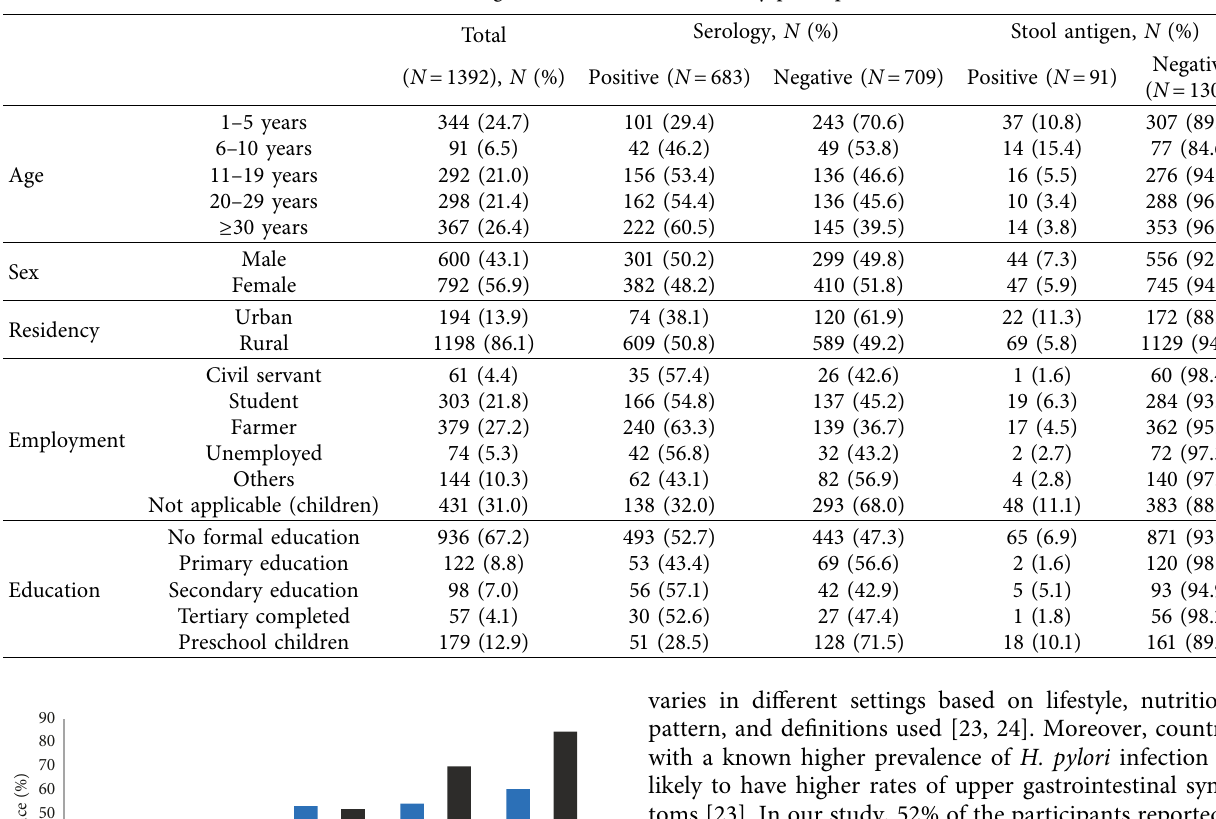
Table 1: Background characteristic of study participants.